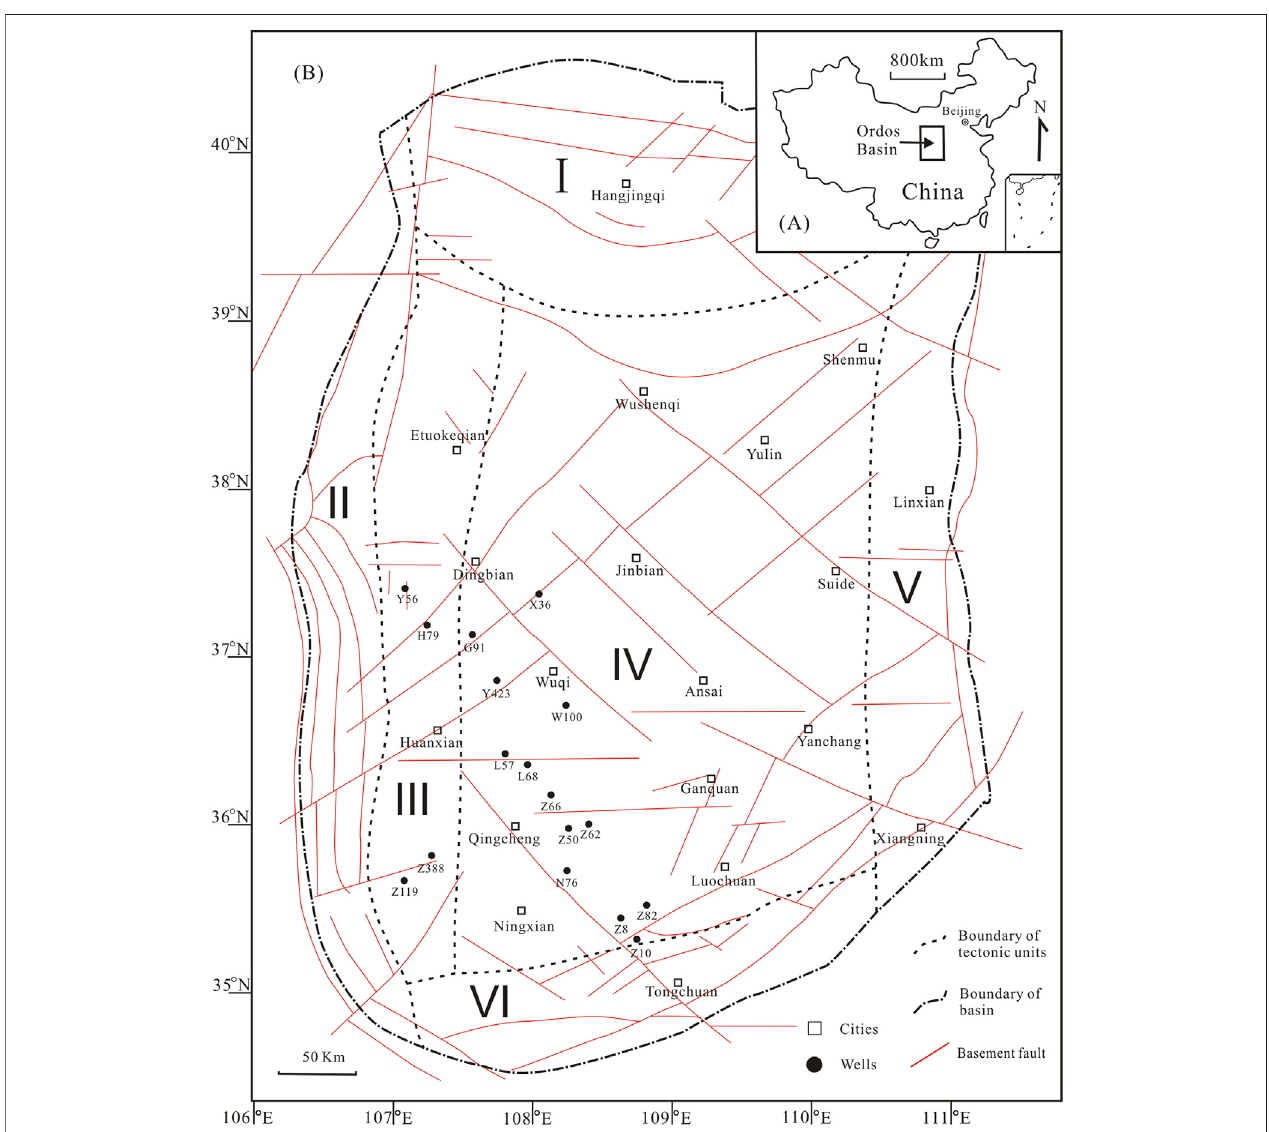
FIGURE 2 | Location of the Ordos Basin, its tectonic division, distribution of basement faults, and the location of sample wells (modi fi ed after Qiu, 2011). I-Yimeng uplift; II-West margin thrust belts; III-Tianhuan depression; IV-Yishan slope; V-Jinxi fl exure belts; VI-Weibei uplift.